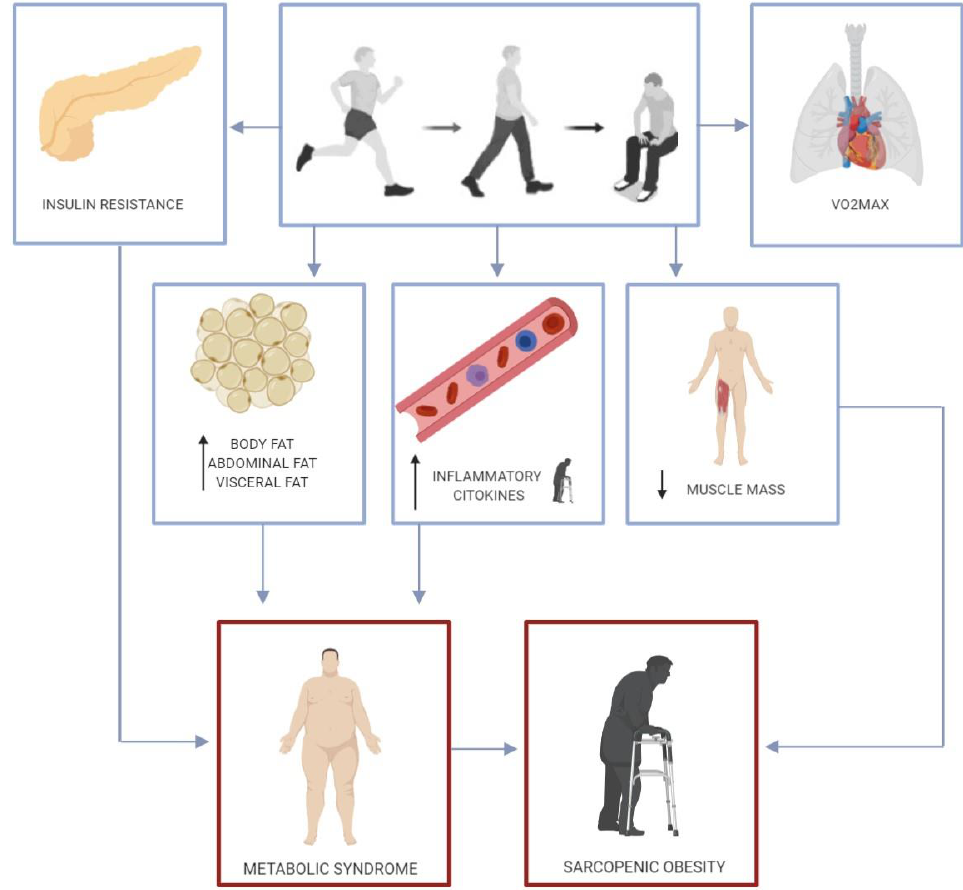
Figure 2. Consequences of a short-term reduction in physical activity.